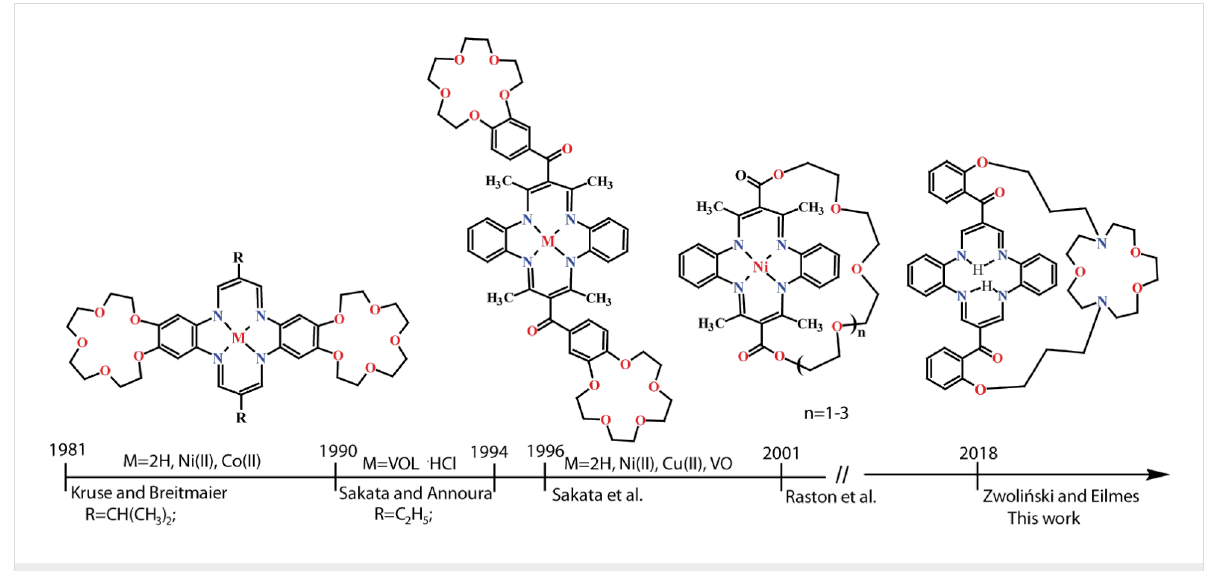
Figure 1: Timeline for the structure evolution of crown-capped DBTAAs (created on the basis of references